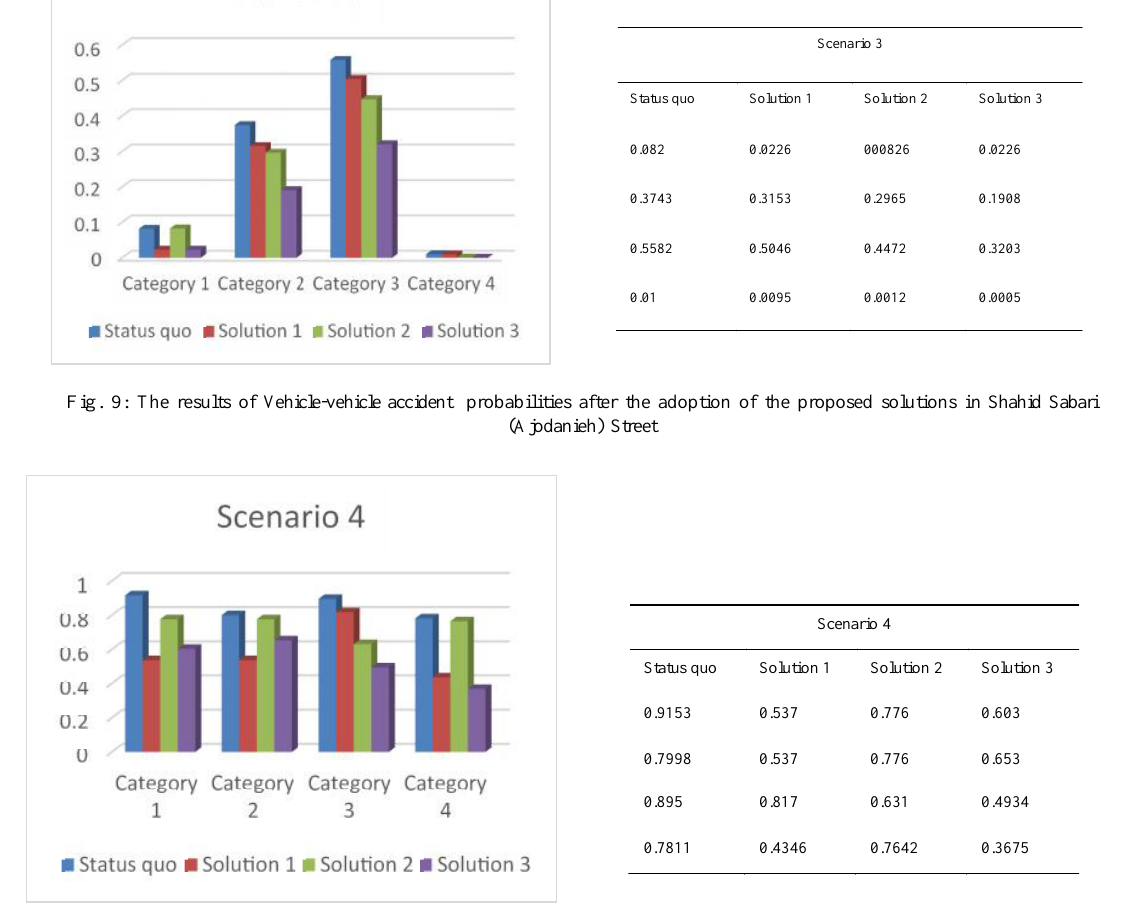
Fig. 10: The results of Vehicle-pedestrian accident probabilities after the adoption of the proposed solutions in Andarzgoo